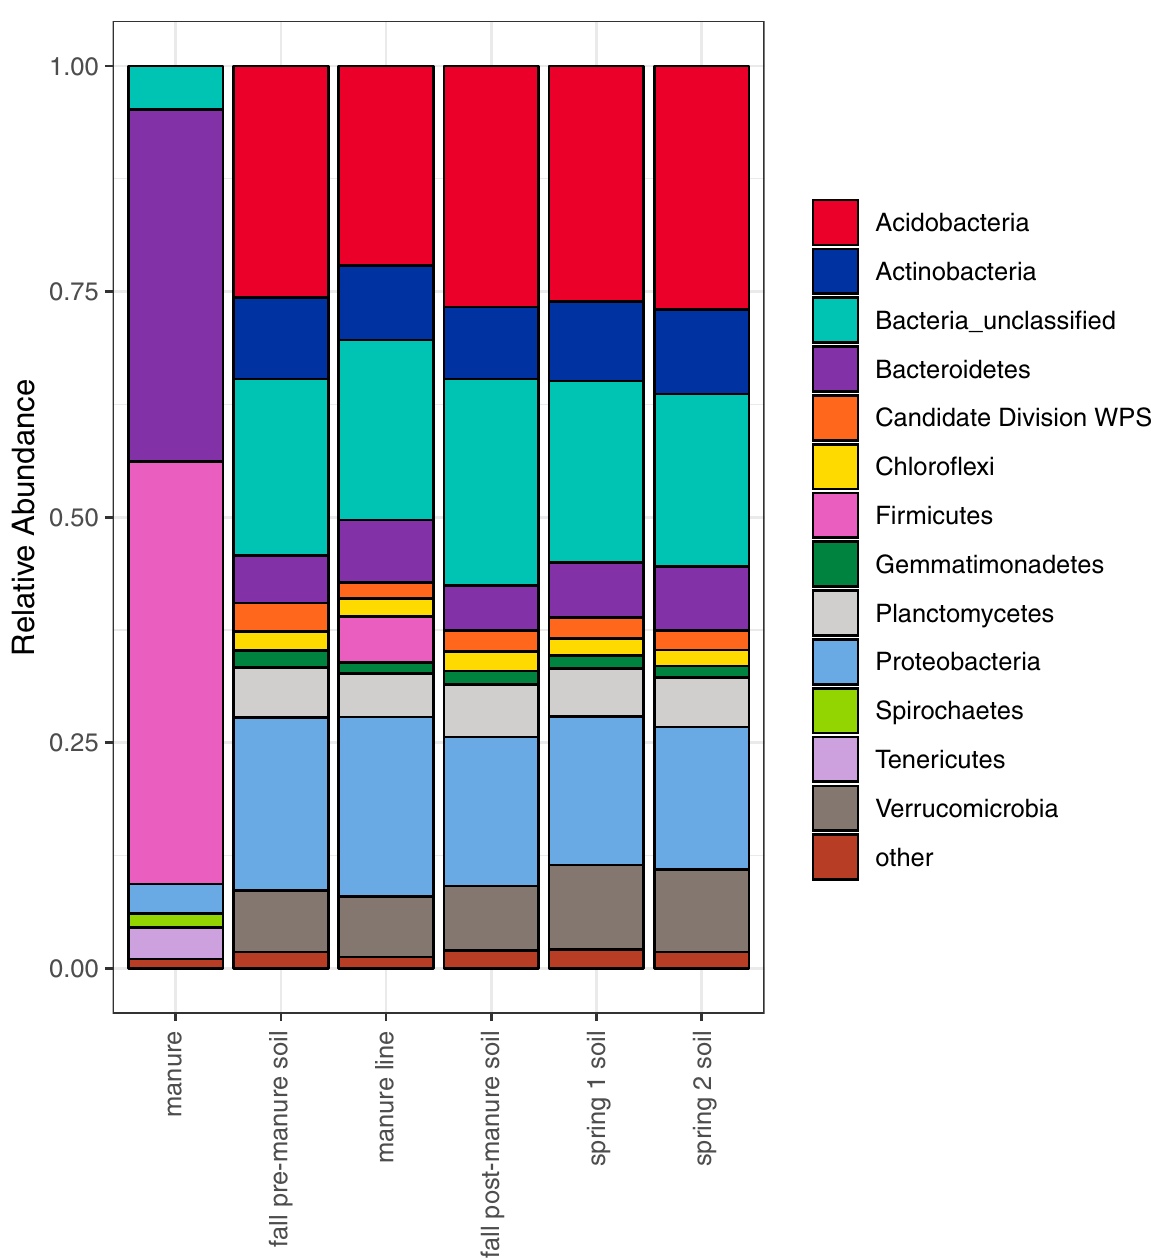
Fig 1. Average relative abundances of phyla among sample types. Included in “Other” are phyla that individually make up less than 1% of total abundance: Nitrospirae, Armatimonadetes, Spirochaetes, Synergistetes, Latescibacteria, BRC1, Parcubacteria, Microgenomates,